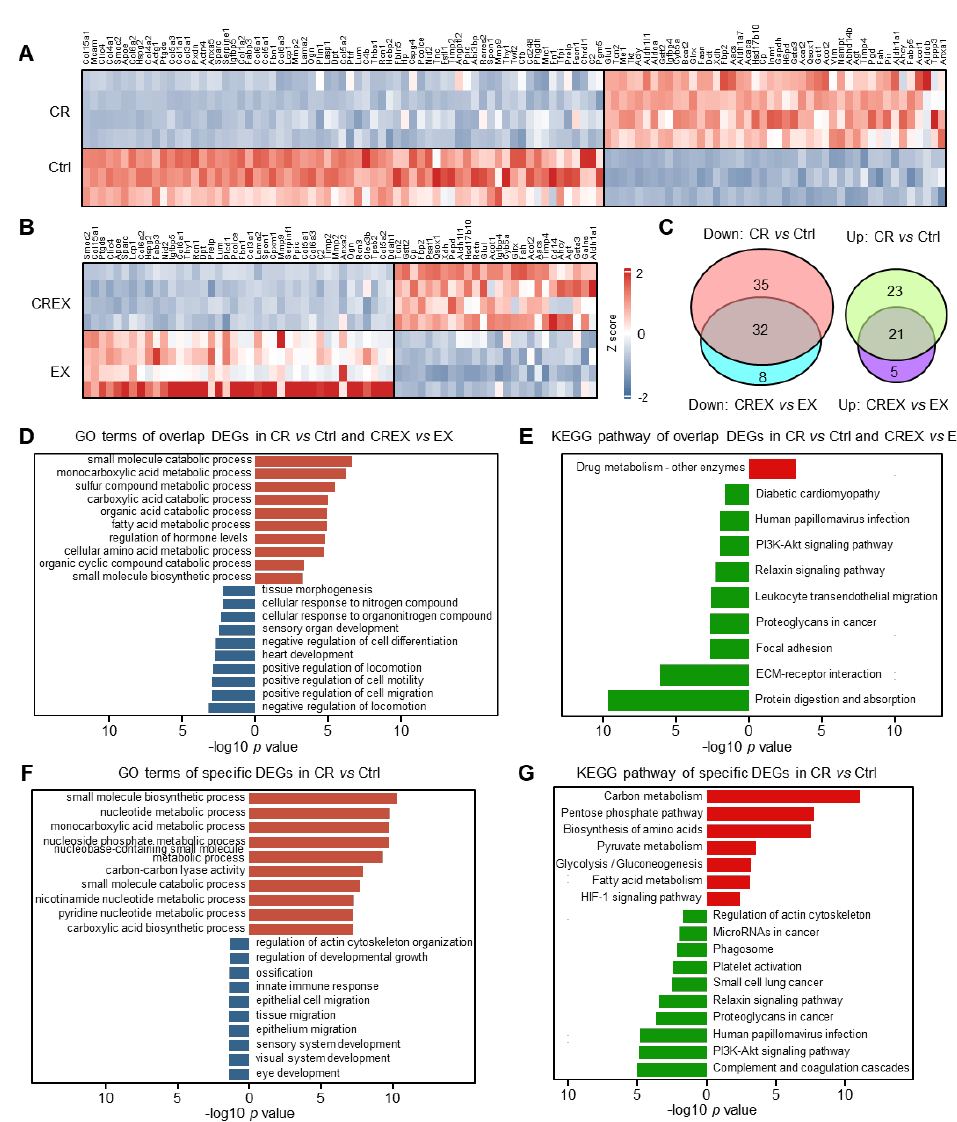
Figure 3. GO terms and KEGG pathways enriched by DEGs encoding adipokines upon CR with or without EX. ( A , B ) Heatmap plot of DEGs encoding adipokines in CR vs. control groups ( A ) and in CREX vs. EX groups ( B ). ( C ) Venn plot of common and distinct DEGs encoding adipokines upon CR with or without EX. ( D ) Enriched GO terms for common DEGs encoding adipokines in BAT upon CR with or without EX. ( E ) Enriched KEGG pathways for common DEGs encoding adipokines in BAT upon CR with or without EX. ( F ) Enriched GO terms for specific DEGs encoding adipokines in BAT upon CR. ( G ) Enriched KEGG pathways for specific DEGs encoding adipokines in BAT upon CR. Brick red, enriched GO terms for upregulated DEGs encoding adipokines; navy blue, enriched GO terms for downregulated DEGs encoding adipokines; bright red, enriched KEGG pathways for upregulated DEGs encoding adipokines; green, enriched KEGG pathways for downregulated DEGs encoding adipokines.